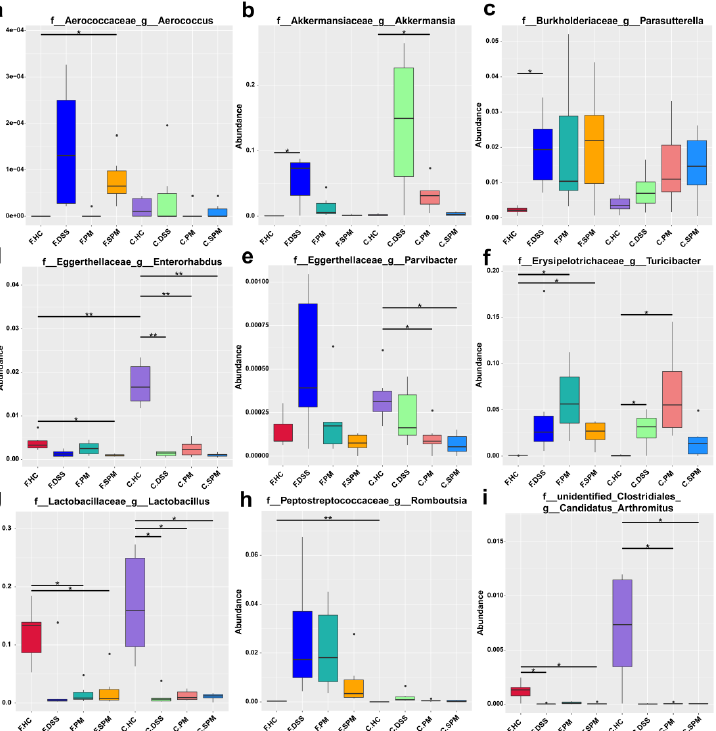
Figure 7. Significant differences in gut flora species abundances at the genus level. ( a ) Aerococcus ; ( b ) Akkermansia ; ( c ) Parasutterella ; ( d ) Enterorhabolus ; ( e ) Parvibacter ; ( f ) Turicibacter ; ( g ) Lactobacillus ; ( h ) Romboutsia ; ( i ) Arthromitus. * p < 0.05, ** p < 0.01.